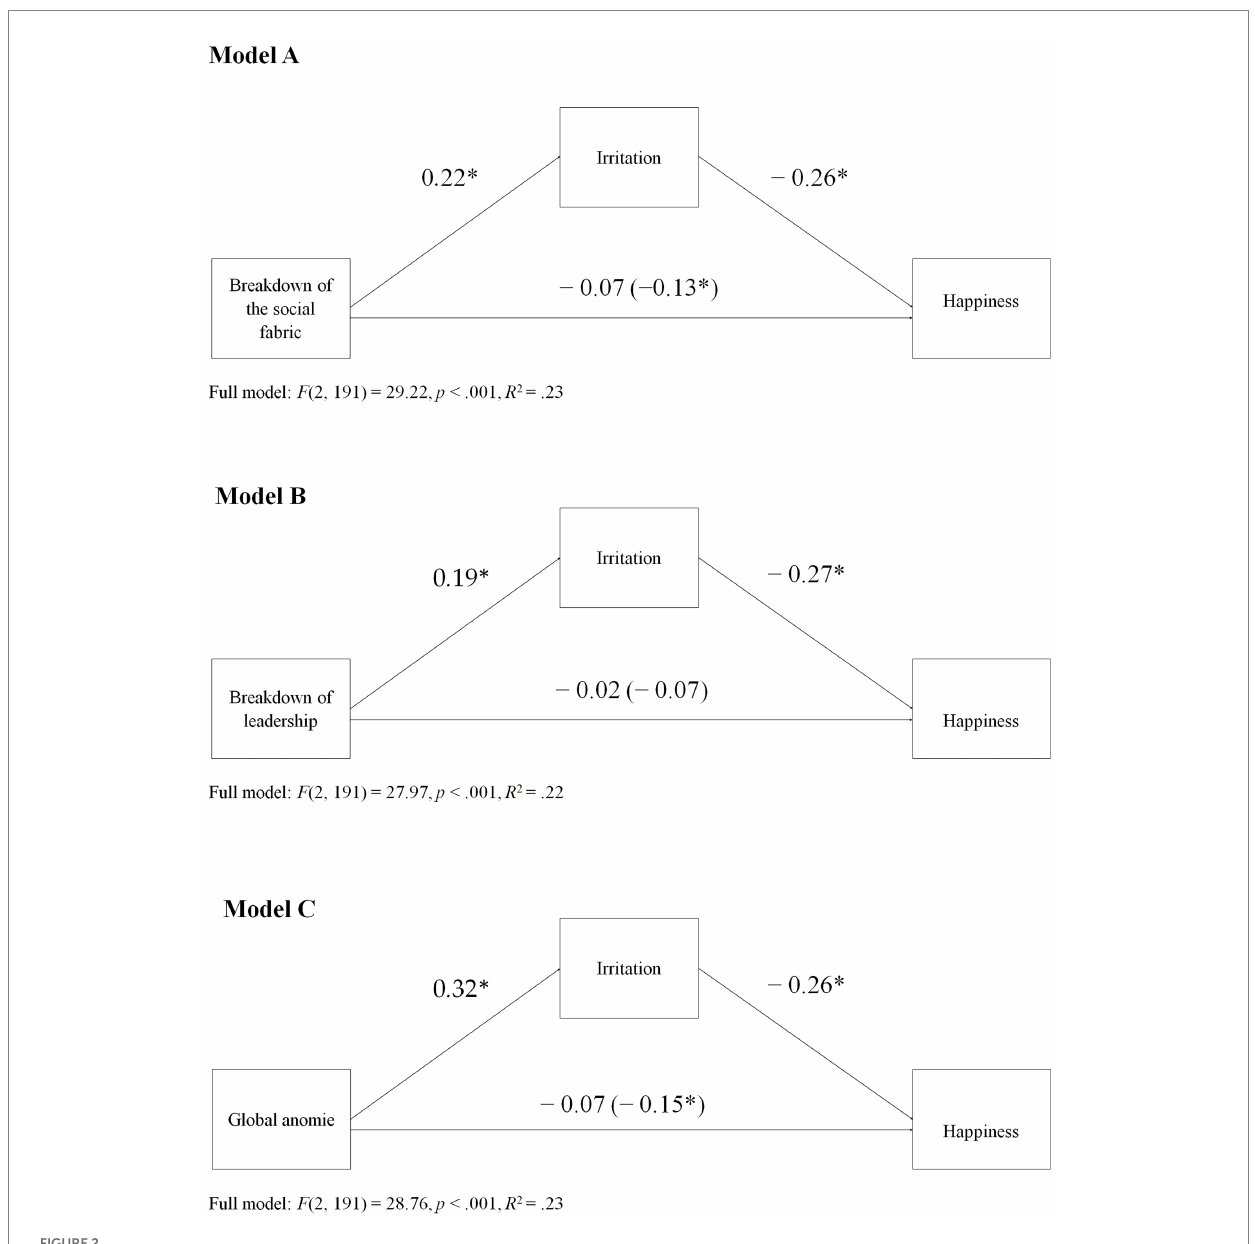
FIGURE 2 Influence of anomie and its core dimensions on happiness through